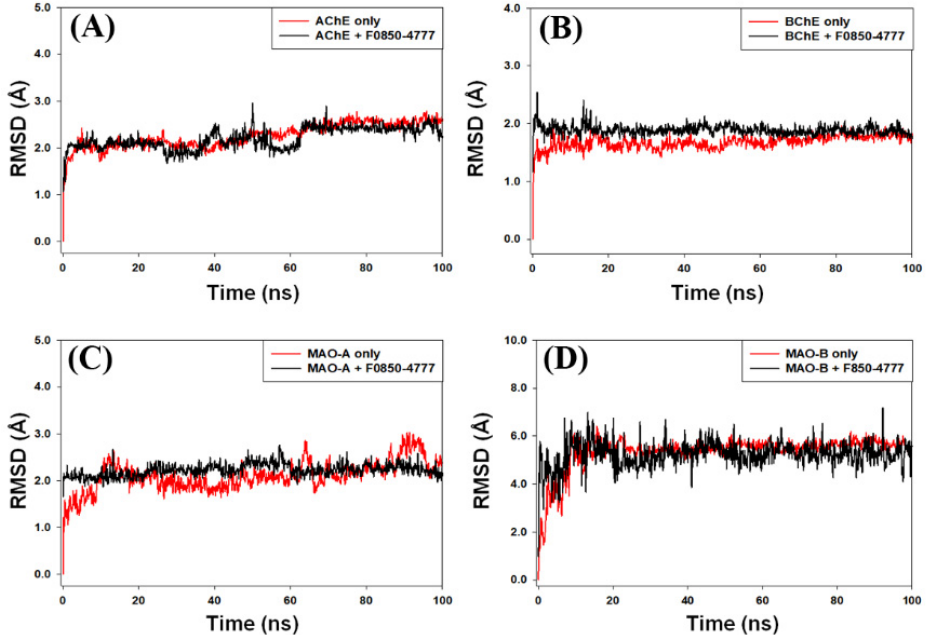
Figure 5. Behavior of root mean square deviation (RMSD) of ( A ) AChE, ( B ) BChE, ( C ) MAO-A, and ( D ) MAO-B alone or in complex with ( D ) MAO-B alone or in complex with F0850-4777.